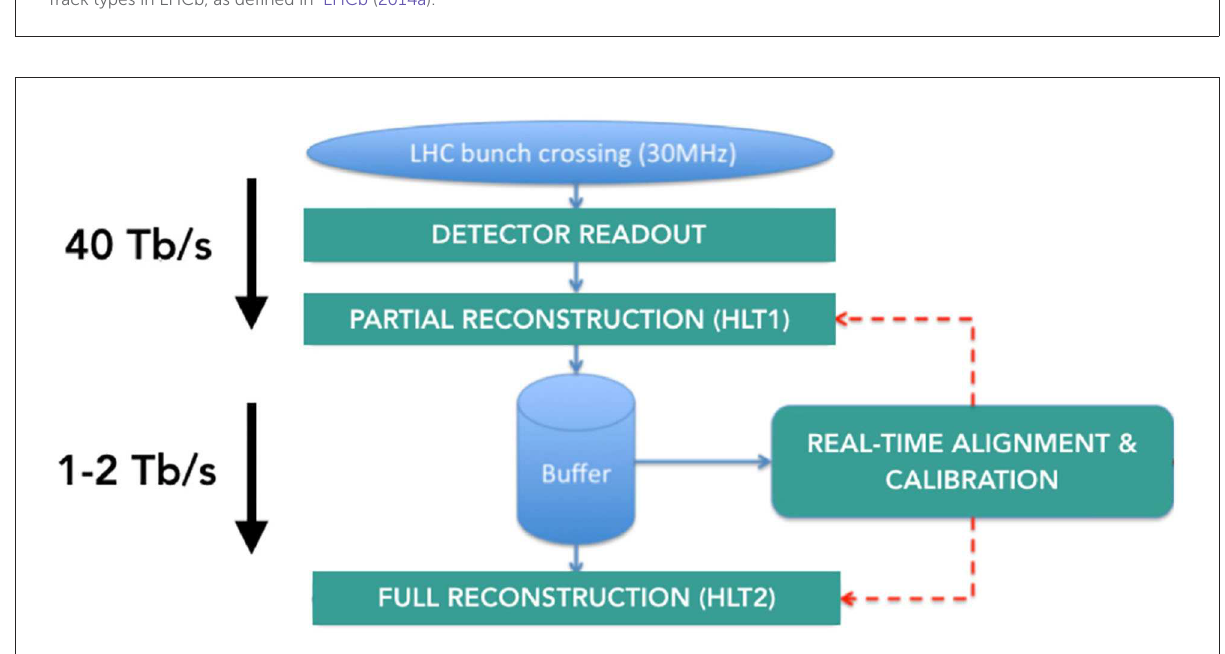
FIGURE4 Dataflow for the first level of the trigger in the upgraded LHCb detector.